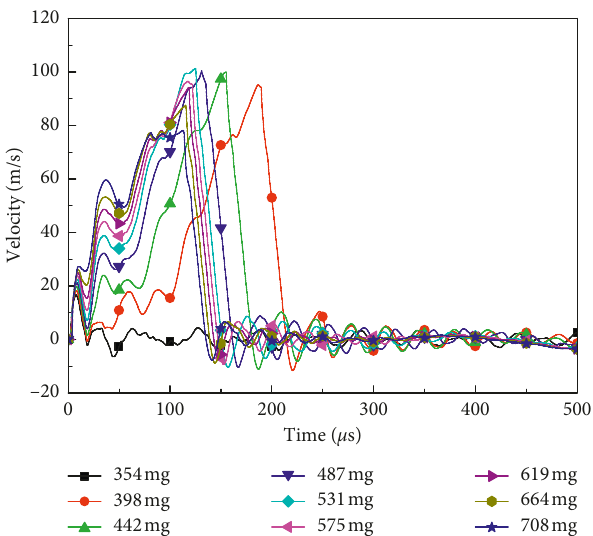
Figure 19: Displacements of the piston under different charge amounts.